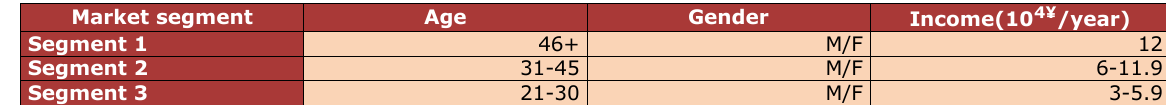
Table 5. Customer groups in the